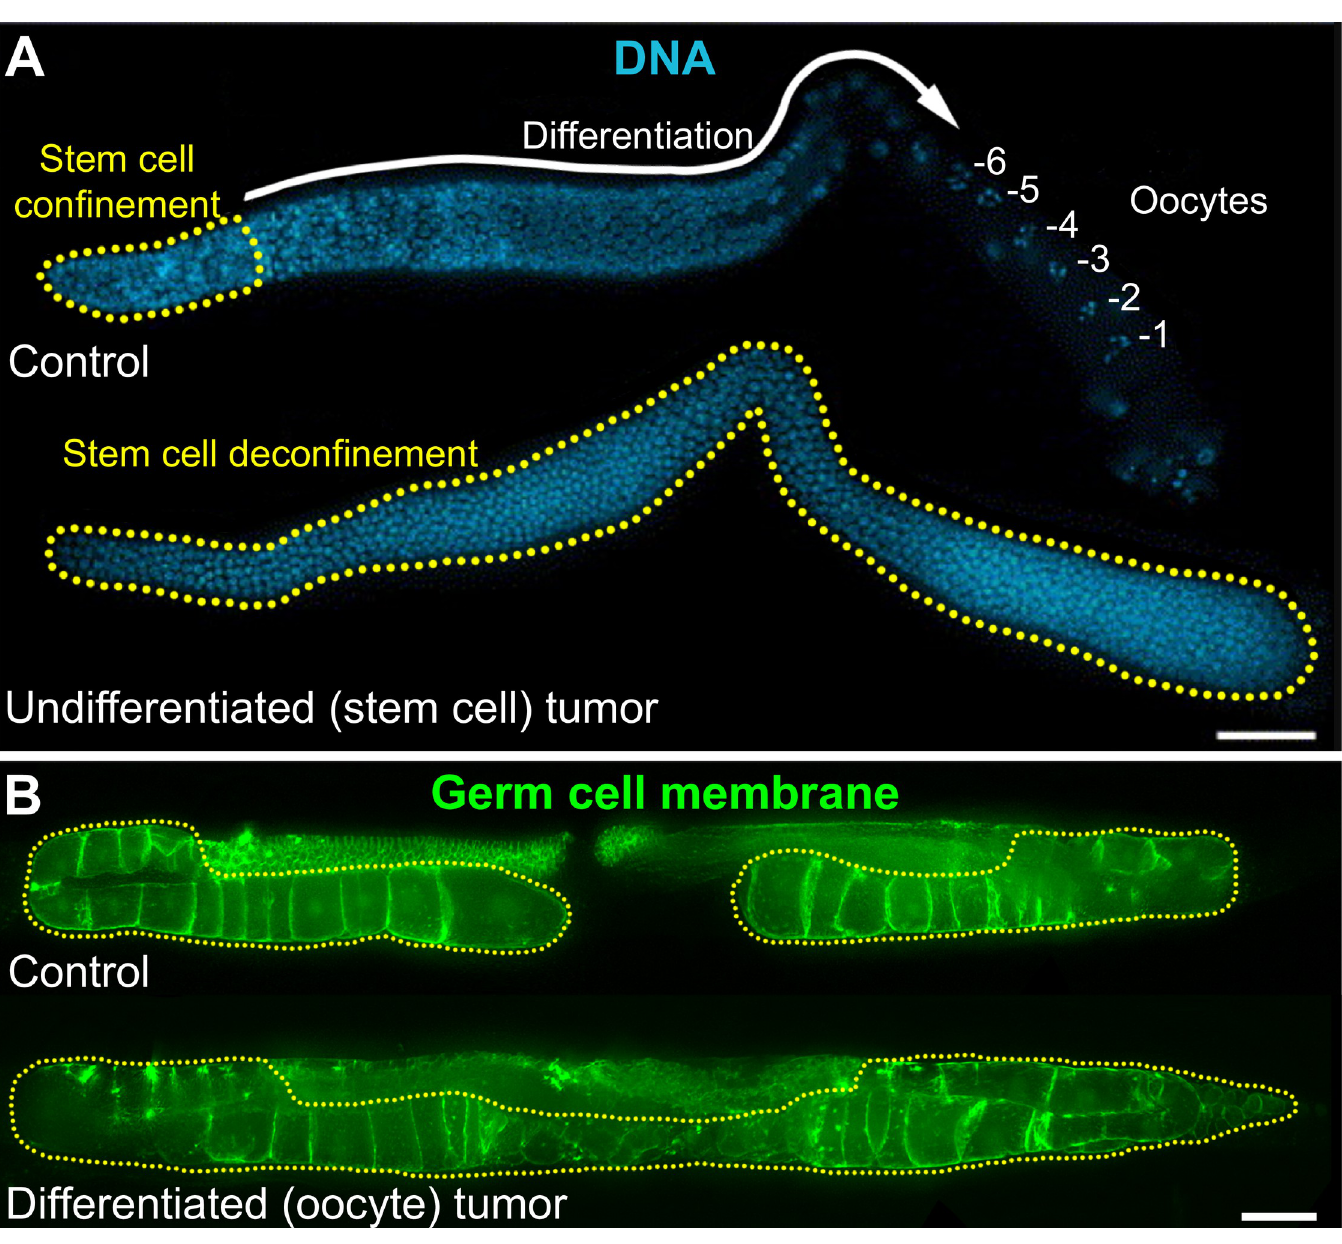
Fig 4. Undifferentiated and differentiated benign germline tumors in C . elegans . (A) Undifferentiated mitotic germ cells (yellow dots) are confined within the niche in wild-type C . elegans hermaphrodites (top), but not in Notch gain-of-function mutants (bottom). Scale bar, 20 μ M. Reproduced with permission [123]. (B) When oocytes are not fertilized in C . elegans hermaphrodites (top), they accumulate up to a certain point (yellow dots), after which homeostatic signaling limits any further SC proliferation and oocyte production. In mutants that disrupt homeostatic signaling however, such as aak-1 /AMPK null mutants, GSC proliferation and oocyte production do not stop, and if laying is prevented, differentiated benign tumors develop. Scale bar, 50 μ M. Reproduced with permission [35]. GSC, germline stem cell; SC, stem